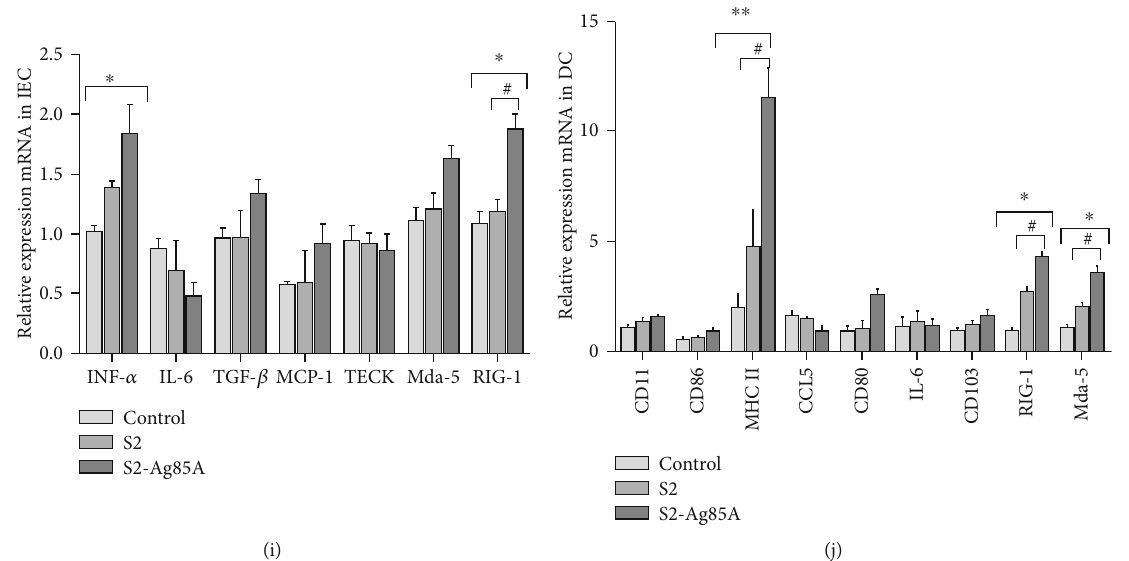
Figure 2: The S2-Ag85A vaccine promotes antibody secretion from IEC and DC cells to reduce the production of proin fl ammatory factors. ELISA to detect (a) IFN- β expression in IEC and DC cells, with signi fi cantly increased IFN- β expression in DC cells of the S2-Ag85A group ( P < 0 : 05 ); (b) IFN- γ expression in IEC and DC cells, with signi fi cantly increased IFN- γ expression in DC cells of the S2-Ag85A group ( P < 0 : 05 ); (c) IL-1 β expression in IEC and DC cells, with signi fi cantly increased IL-1 β expression in the S2-Ag85A group ( P < 0 : 05 ); (d) IL-1 β expression in IEC and DC cells, with signi fi cantly lower expression of IL-1 β in the S2-Ag85A and S2 groups than the control group; (e) MIP-1 α expression in IEC cells, with signi fi cantly increased expression in the S2-Ag85A group ( P < 0 : 05 ); (f) ICA-M1 expression in IEC cells, with signi fi cantly lower expression in both the S2-Ag85A and S2 groups than in the control group ( P < 0 : 05 ); (g) TLR4 expression in DC cells. (h) CXCL10 expression in DC cells. RT-PCR for (i) IFN- α ( P < 0 : 05 ), IL-6, TGF- β , MCP-1, and TECK and (j) CD11, CD86, MCHII ( P < 0 : 05 ), CCL5, CD80, and IL-6 in IEC